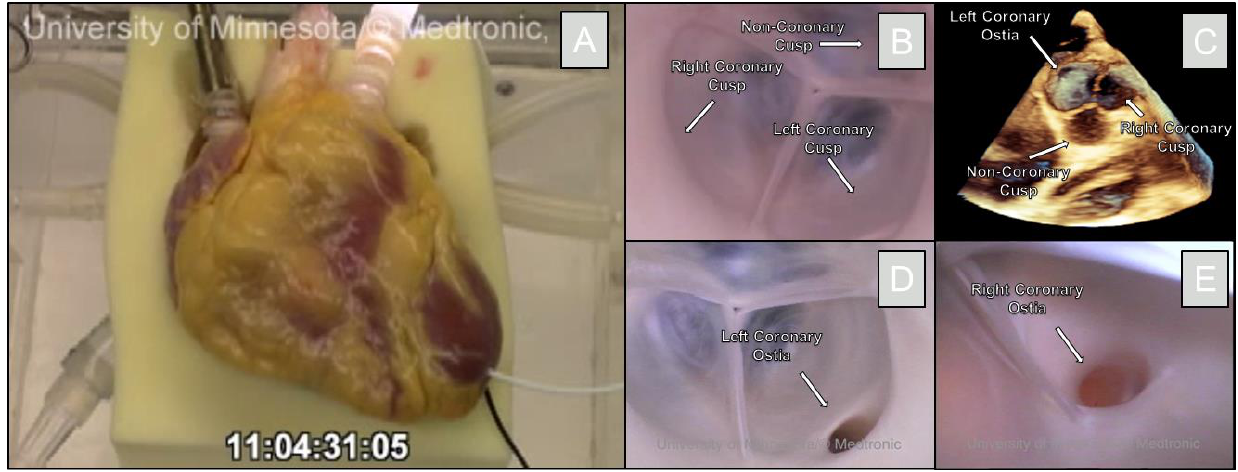
Figure 1. Reanimation and visualization of the aortic valve using Visible Heart ® methodologies. The human heart is shown on the Visible Heart ® apparatus ( A ). An endoscopic camera shows the aortic valve ( B ). A 3D-echo view shows the aortic valve and corresponding cusps ( C ). The endoscopic camera was able to visualize each of the left coronary ostium ( D ), and the right coronary ostium ( E ).